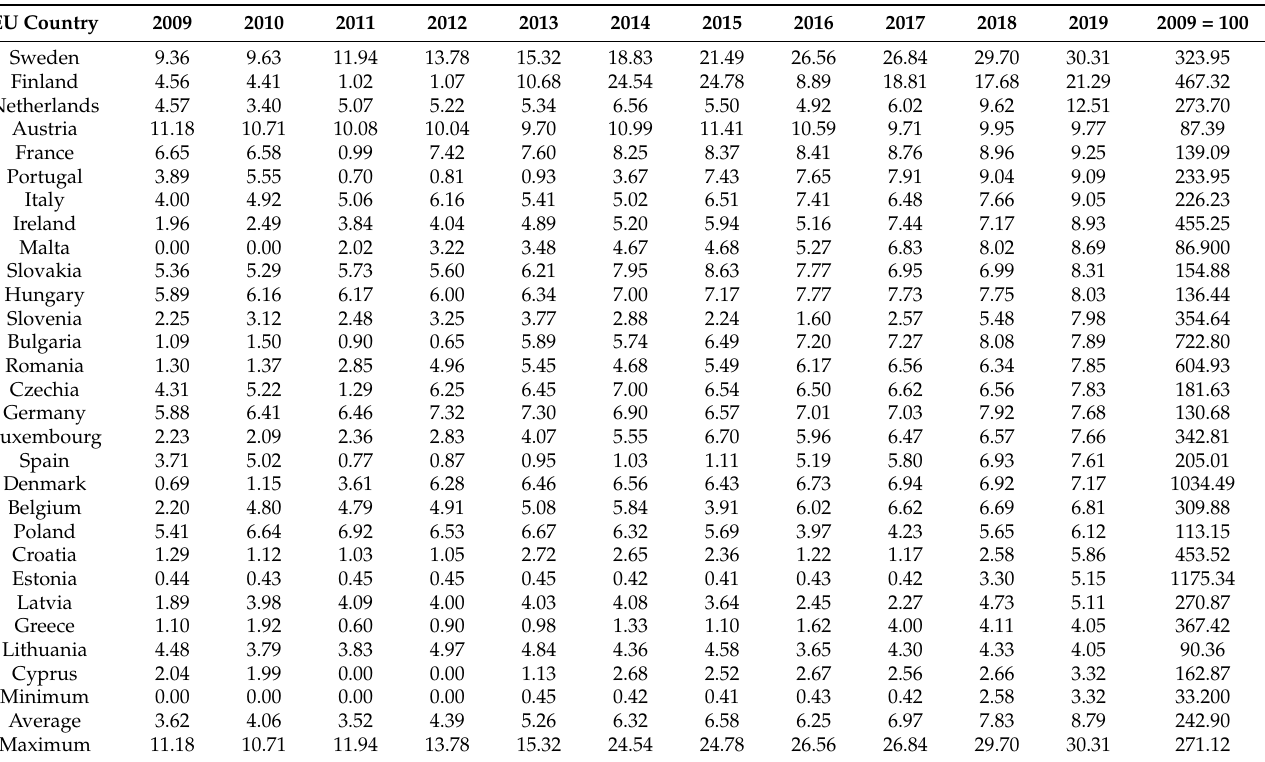
Table 1. Share of renewable energy in transport in years 2009–2019 (Note: countries were ordered by 2019 index value, from highest to lowest).